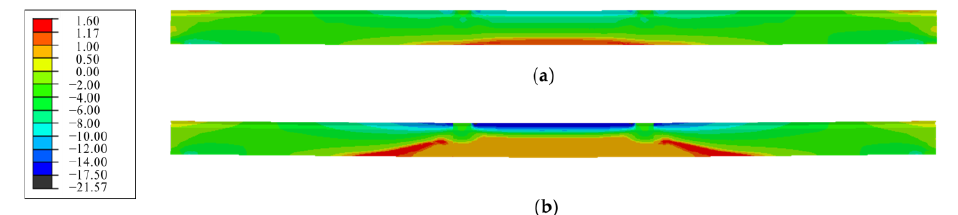
Figure 11. Nephogram of concrete stress along span of the repaired beam under: ( a ) cracking load (0.6 P 0 ); ( b ) service load P 0 .